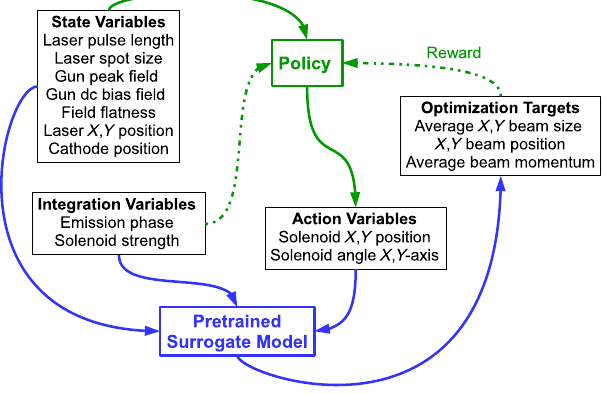
FIG. 4. Schema of the parameters ’ role within the learning loop. The blue arrows indicate the transitions within the pretrained surrogate model. The green elements indicate the training and decision-making by the RL agent. First, the RL agent determines how to choose the action variables using his policy. The state and integration variables are chosen randomly, but we can later measure them in the real experiment. Together with the state and integration variables, these actions get evaluated by the pretrained surrogate model. It returns the optimization targets, which serve as a reward for the policy, from which the RL agent can then improve its policy. Now the learning cycle